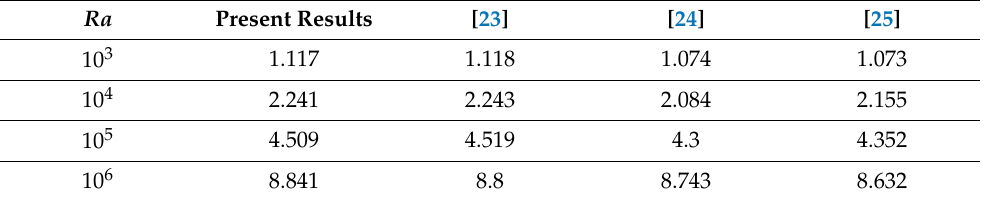
Table 1. Average Nusselt number at the heated wall with the Rayleigh number. Ra Present Results